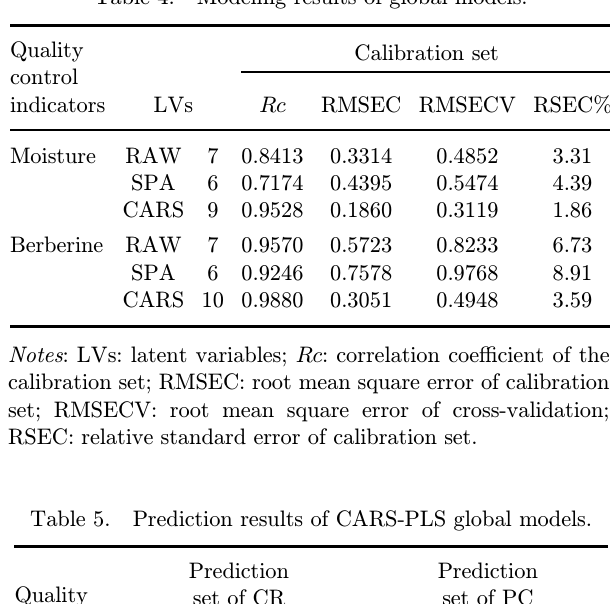
Table 4. Modeling results of global models.